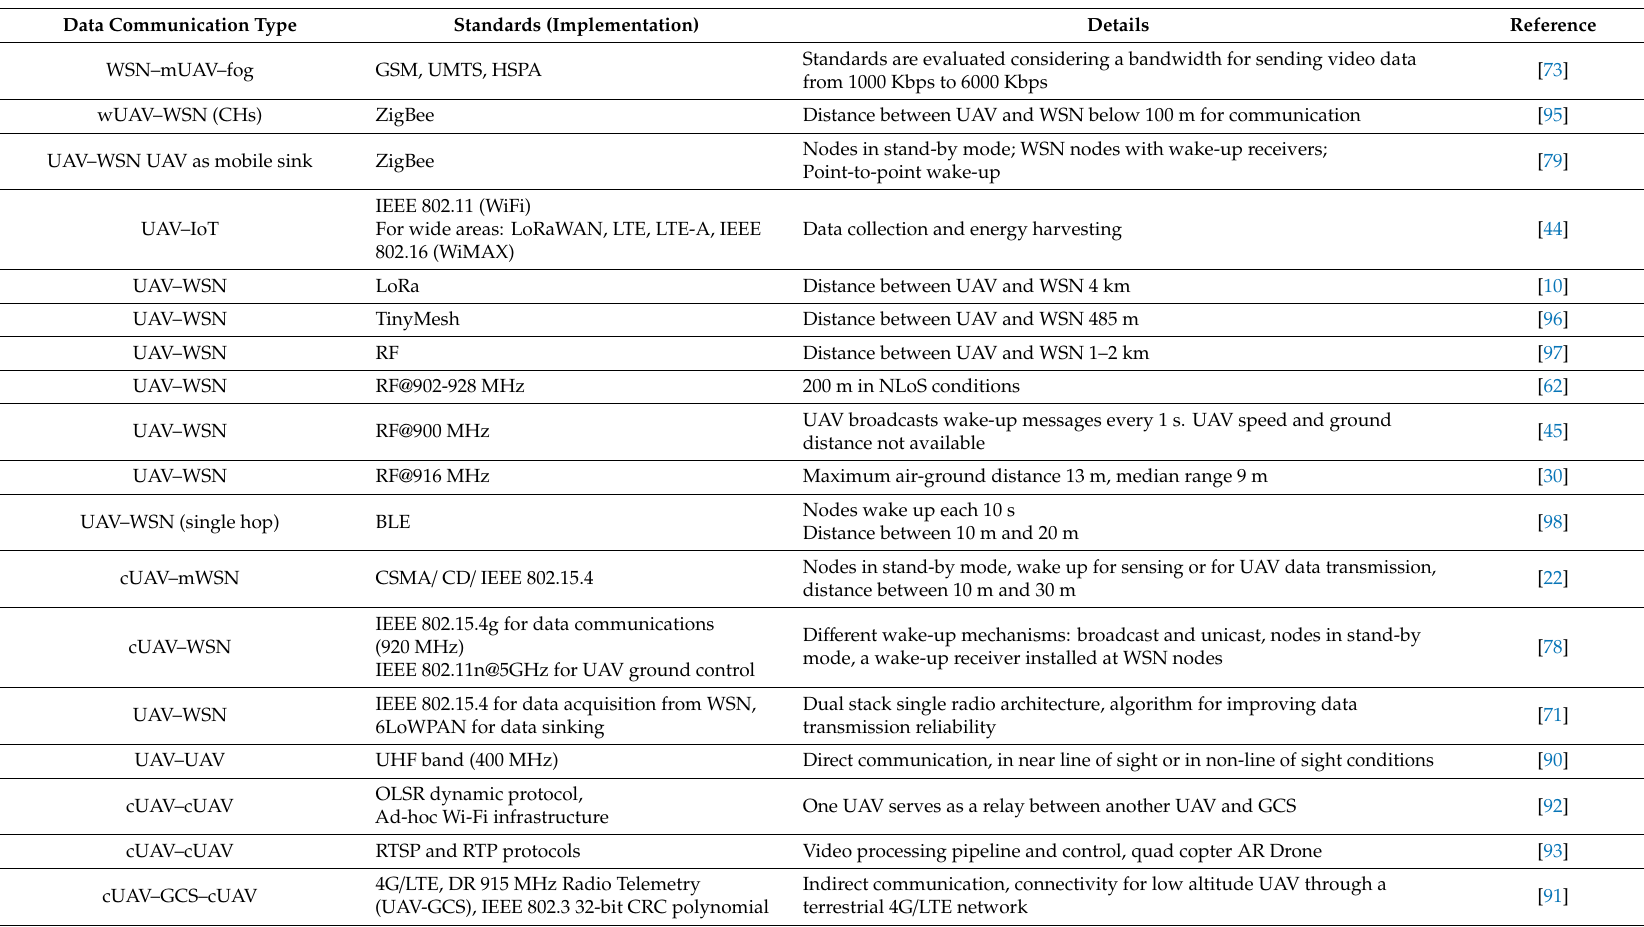
Table 3. Data communication in integrated UAV–WSN